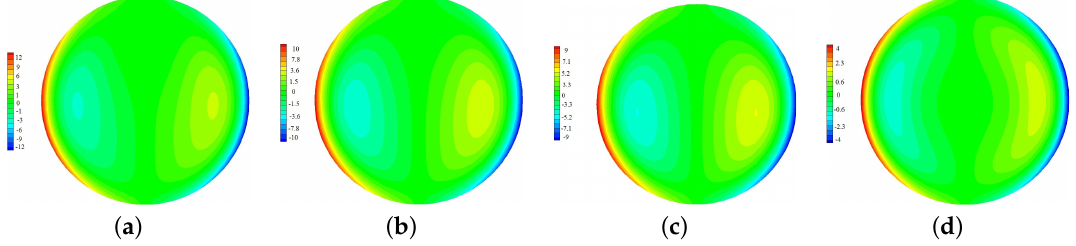
Figure 11. Contours of the streamwise vorticity at z = 0.8 m: ( a ) ϕ = 0; ( b ) ϕ = 0.006; ( c ) ϕ = 0.01; and ( d ) ϕ = 0.016. Results obtained for d np = 42 nm, Re = 1600 and Al 2 O 3